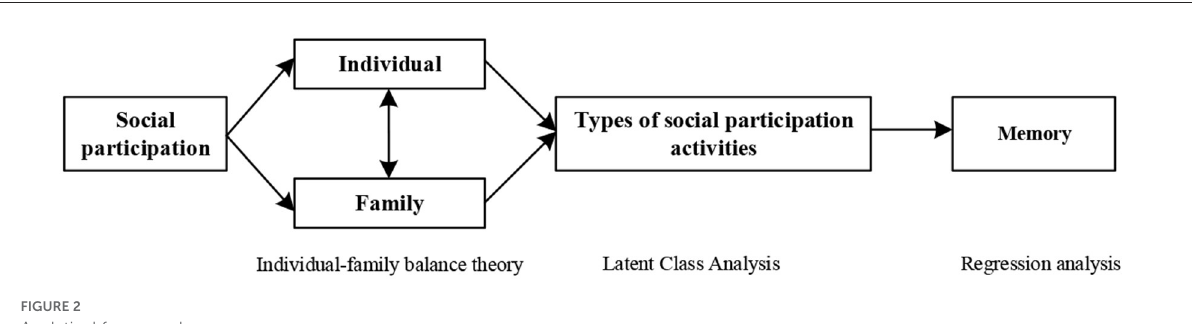
FIGURE2 Analytical